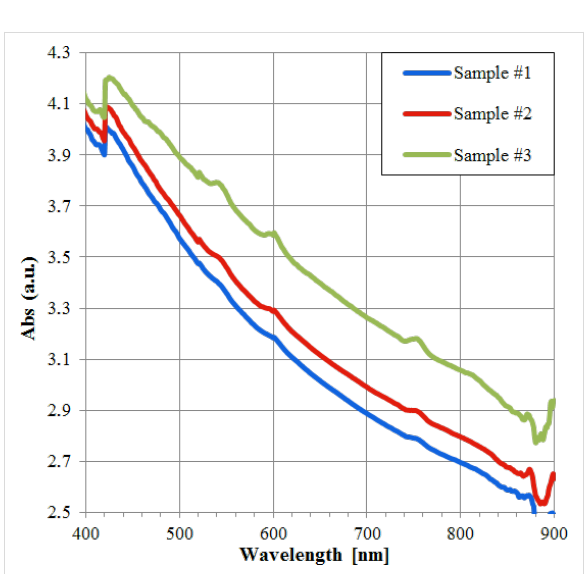
Figure 6: Absorption spectra of MWCNT/ferrocene soon after sonica- tion and magnetic stirring (Sample 1), after one hour (Sample 2) and after a further sonication (Sample